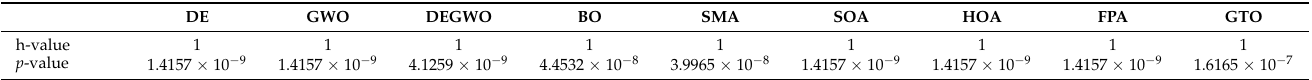
Figure 7. Depiction of I–V and I–P curves obtained using MGTO on test case 2: ( a ) I–P measured against I–P computed; ( b ) I–V measured against I–V computed. Table 6. Comparison under Wilcoxon rank-sum test on test case